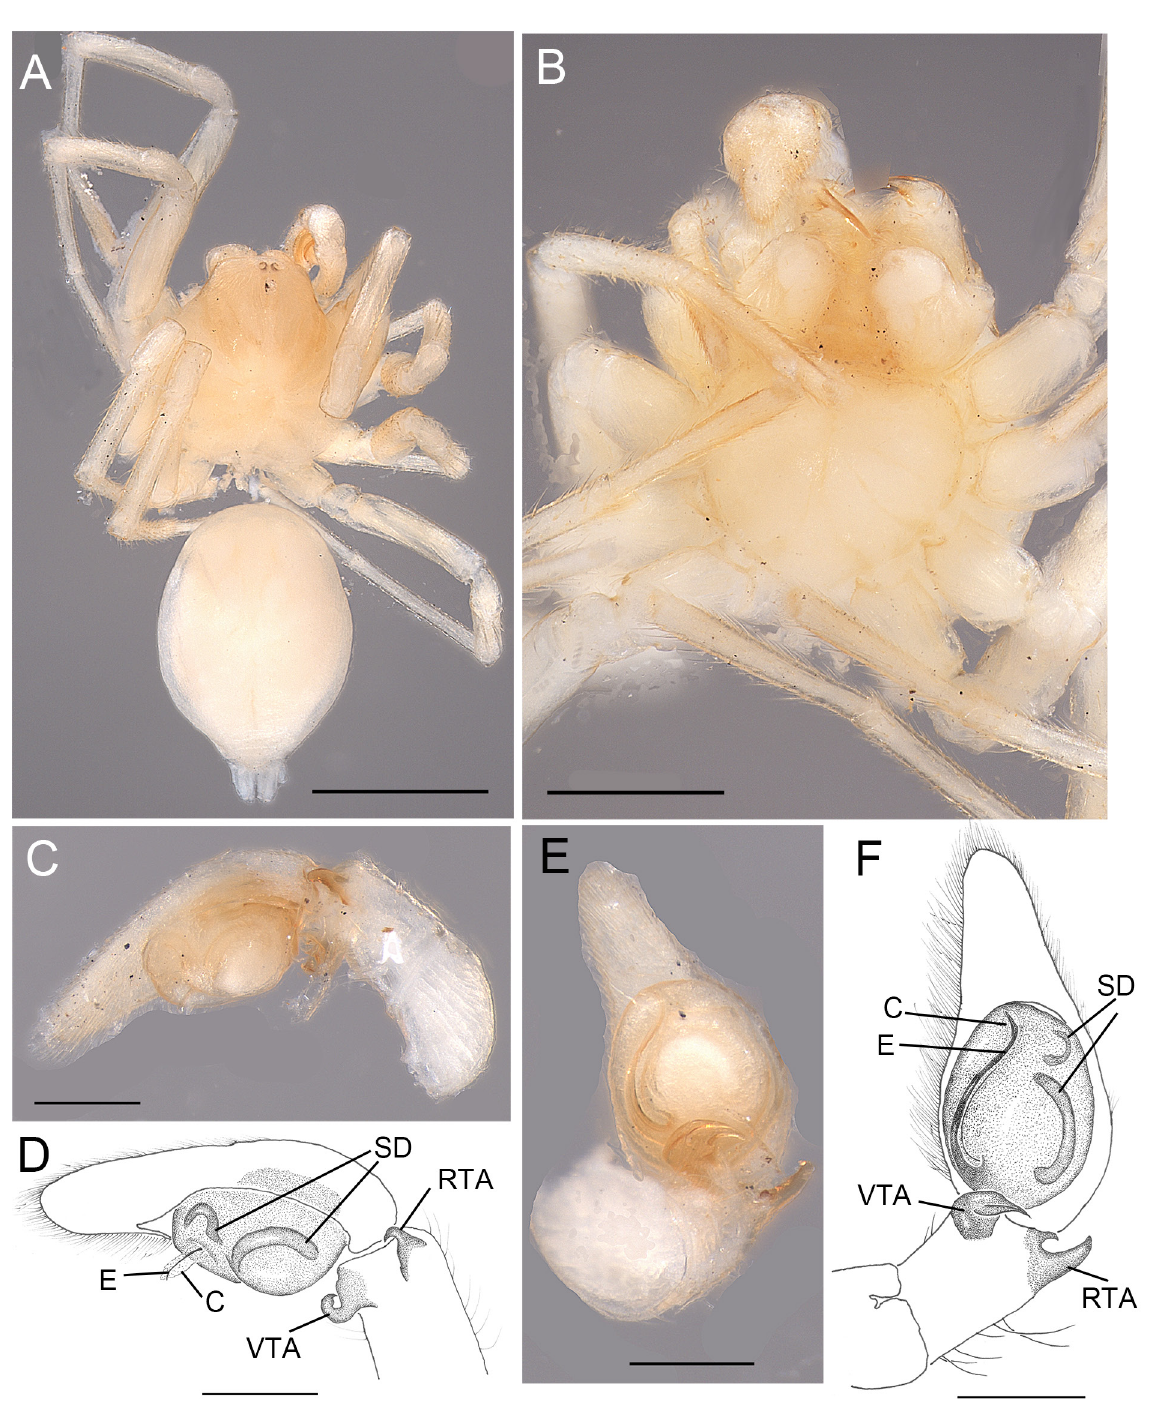
Fig. 4. Andromma aethiopicum Simon, 1893, ♂, lectotype (MNHN AR1678). A . Habitus, dorsal view. B . Cephalothorax, ventral view. C–D . ♂, left palp, retrolateral view. E–F . Same, ventral view. Abbreviations: C = conductor; E = embolus; RTA = retrolateral tibial apophysis; SD = sperm duct; VTA = ventral tibial apophysis. Scale bars: A = 1 mm; B = 0.5 mm; C–F =